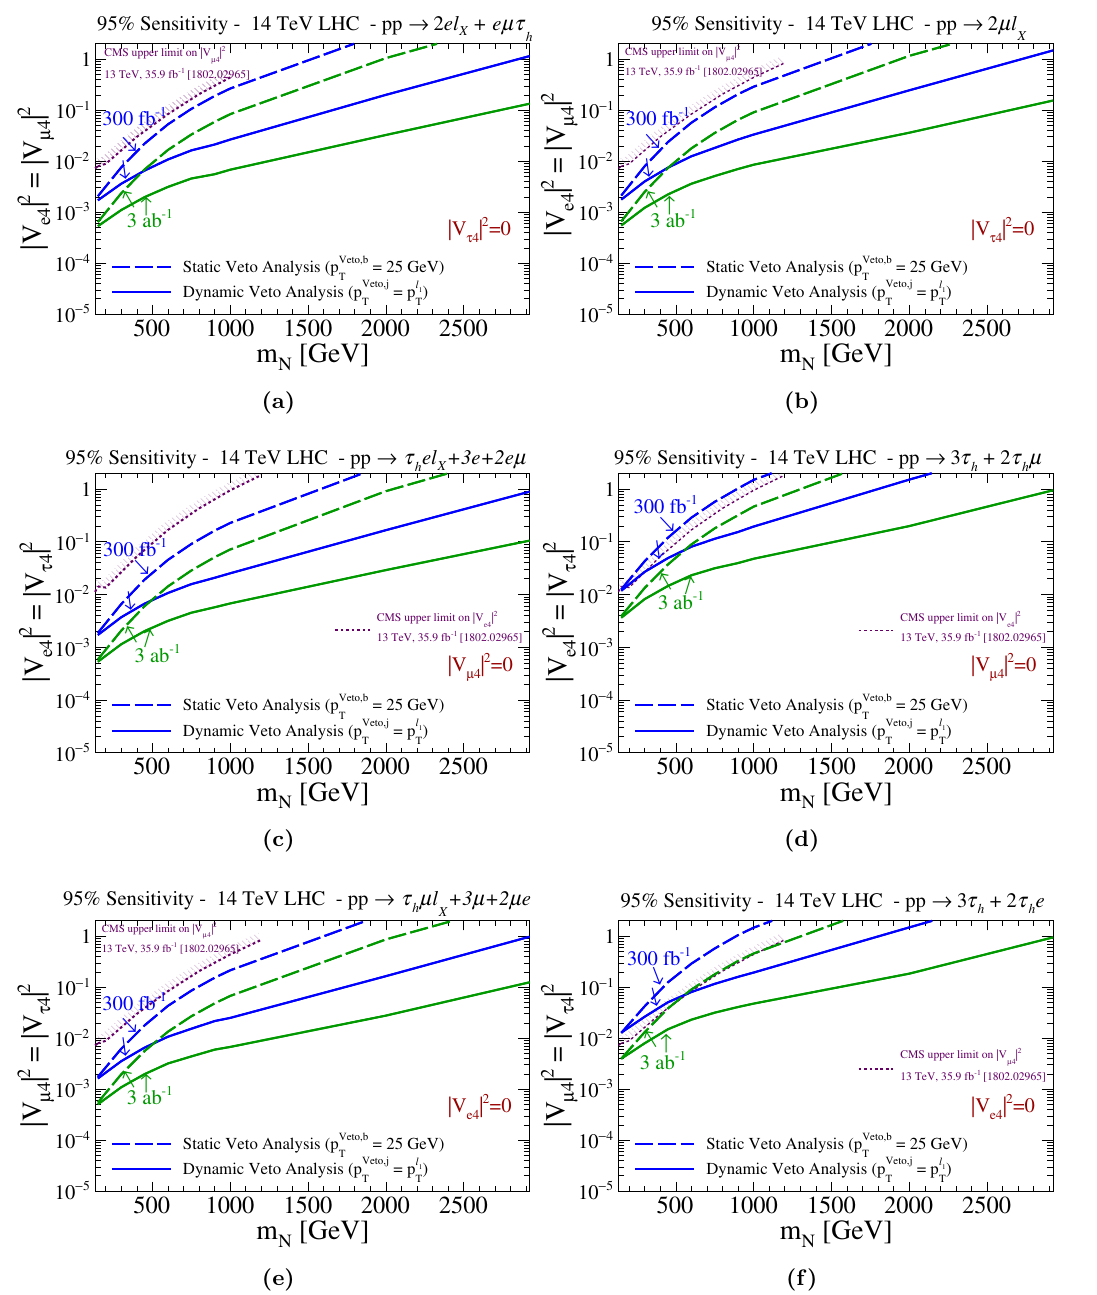
Figure 21. 95% CL sensitivity to active-sterile mixing V ‘ 4 as a function of heavy neutrino mass N j j using the proposed dynamic jet veto trilepton analysis (solid) and the benchmark trilepton analysis (dash), assuming = 300 fb (cid:0) 1 (lower) and 3 ab (cid:0) 1 (upper) at p s = 14 TeV, for the charged lepton L (cid:13)avor violating signal categories (a) EMU-I , (b) EMU-II , (c) ETAU-I , (d) ETAU-II , (e) MUTAU-I , (d) MUTAU-II , as de(cid:12)ned in table 5. Also shown are limits from direct LHC searches [76].